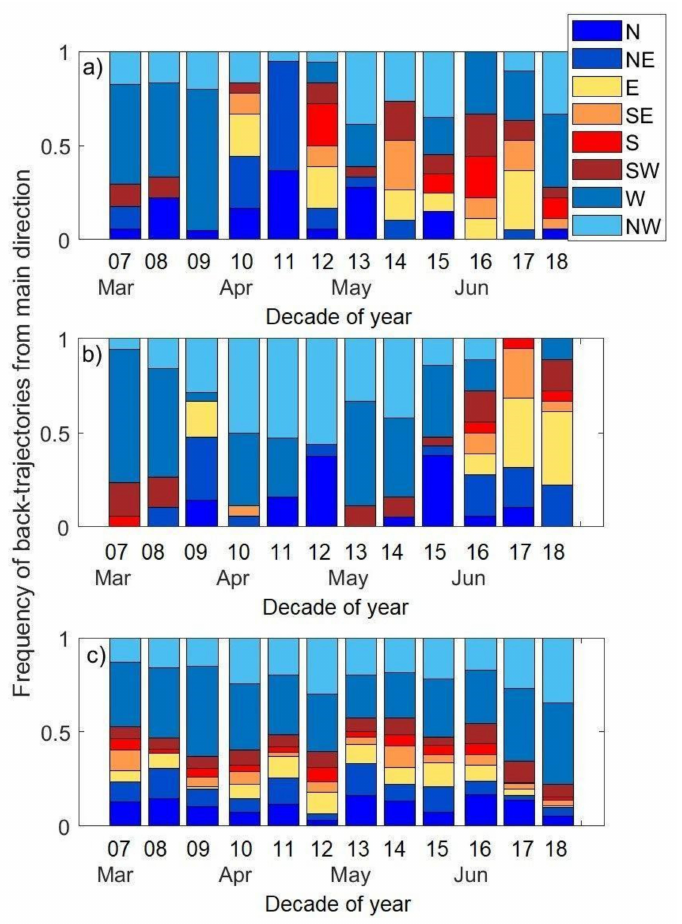
Figure 2. Relative frequency of 96 h back-trajectories at 500 m over Warsaw obtained from HYSPLIT simulation for ( a ) 2019, ( b ) 2020, and ( c ) for 2010–2019. Different colors show the direction of air mass